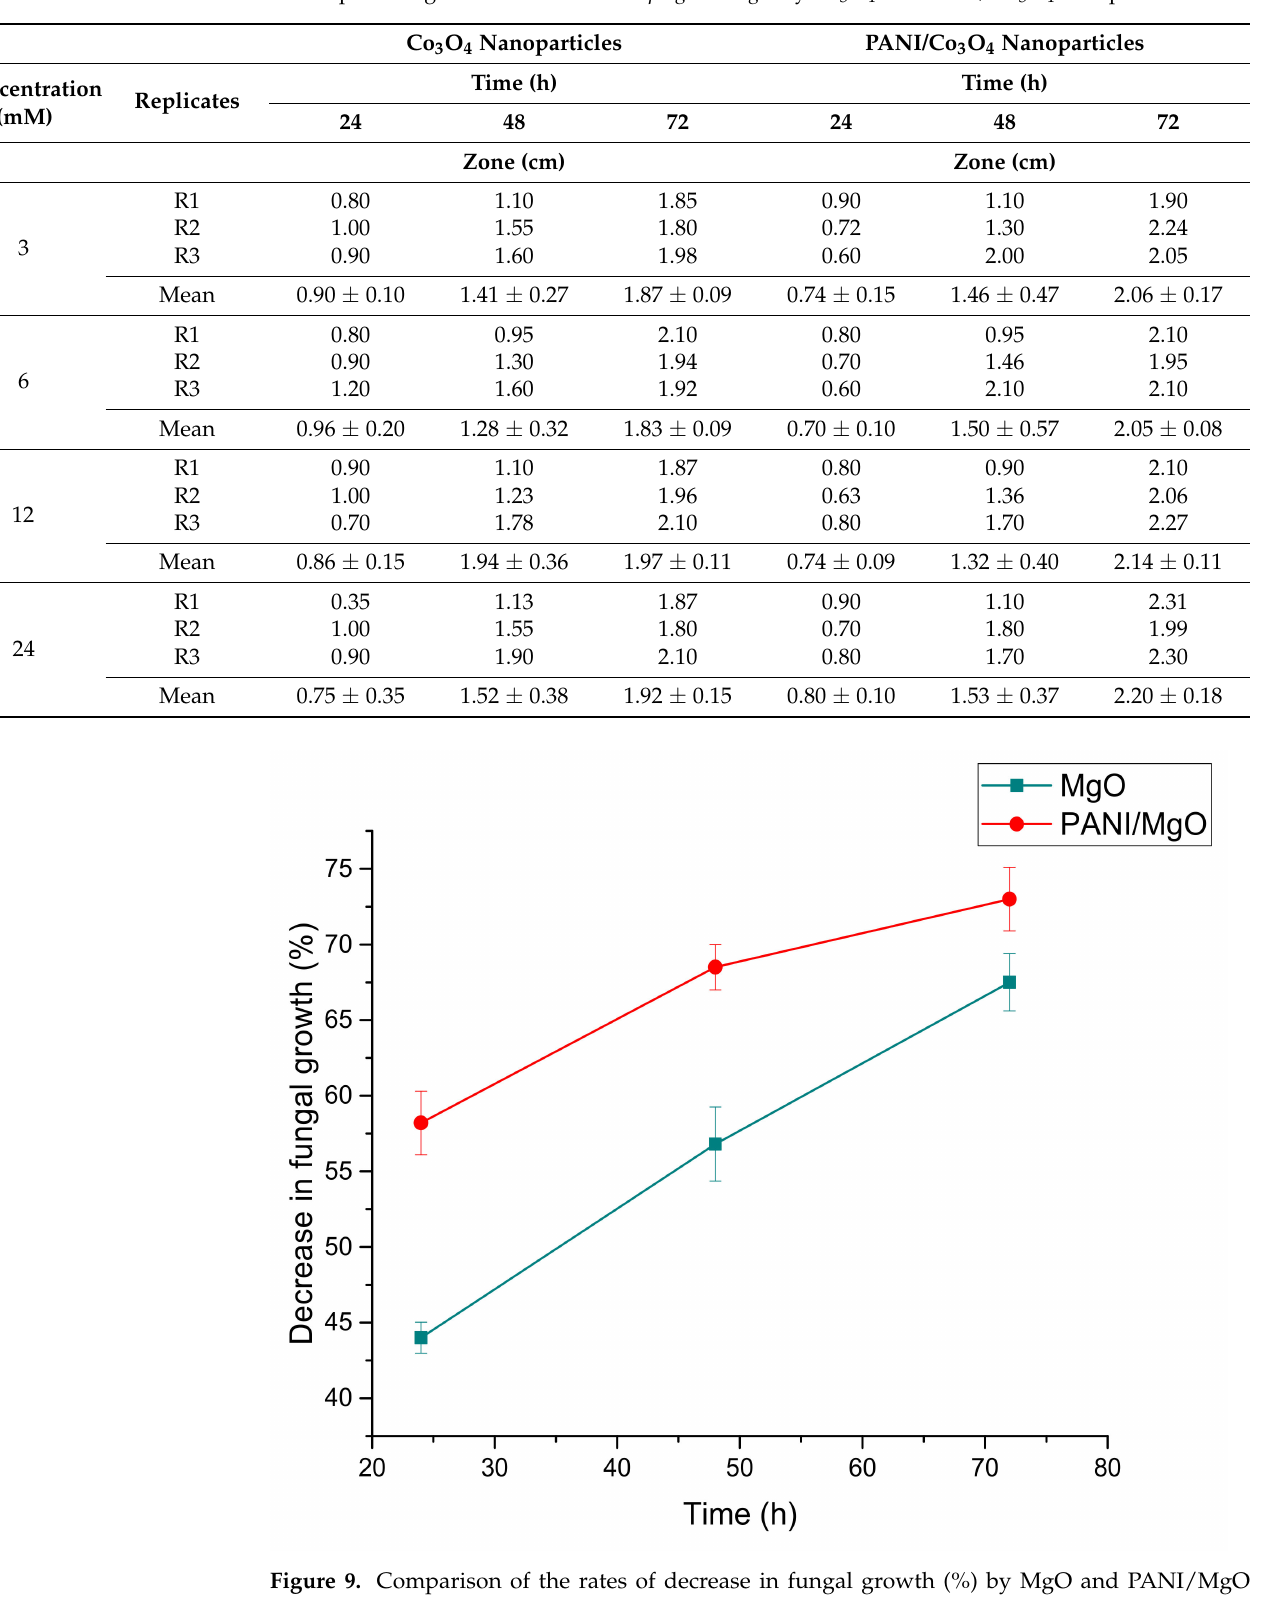
Table 2. Concentration and time-dependent growth inhibition of Aspergillus niger by Co 3 O 4 and PANI/Co 3 O 4 nanoparticles.